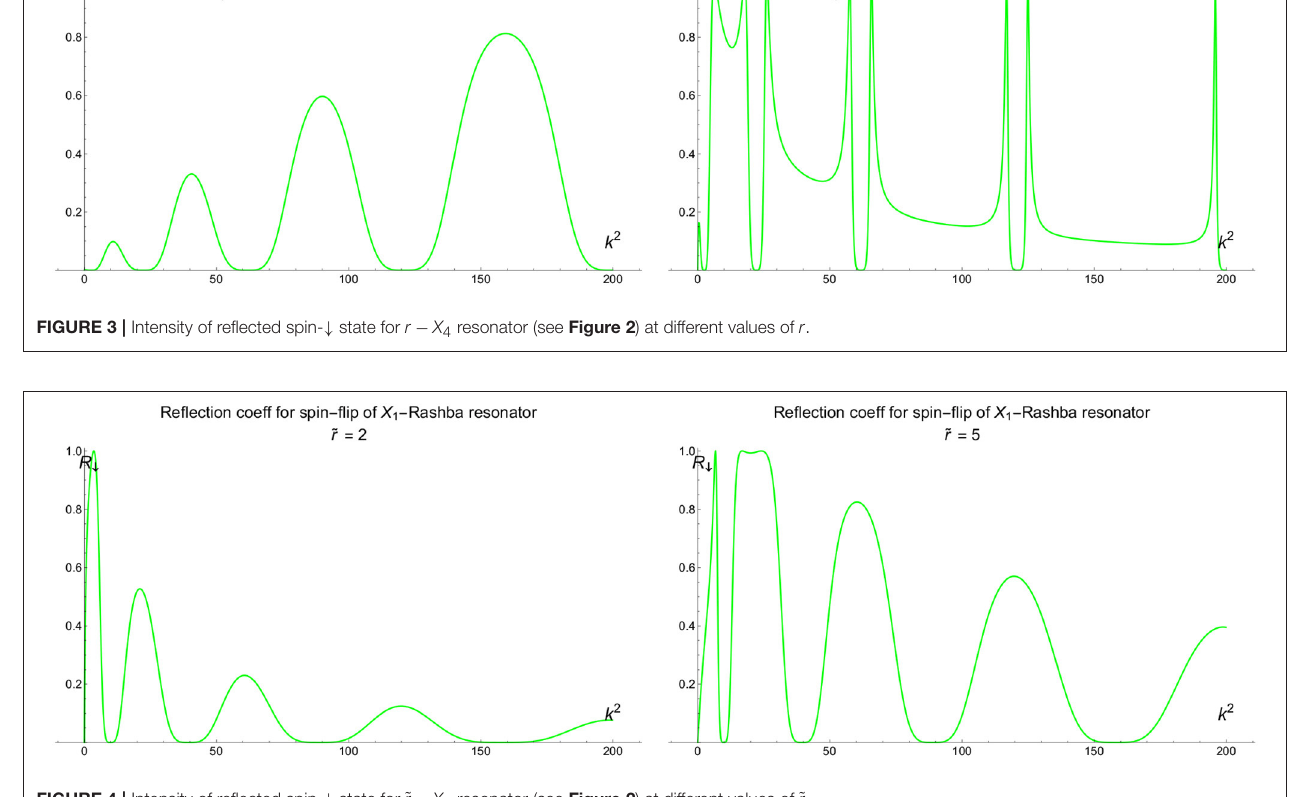
FIGURE 4 | Intensity of reflected spin-